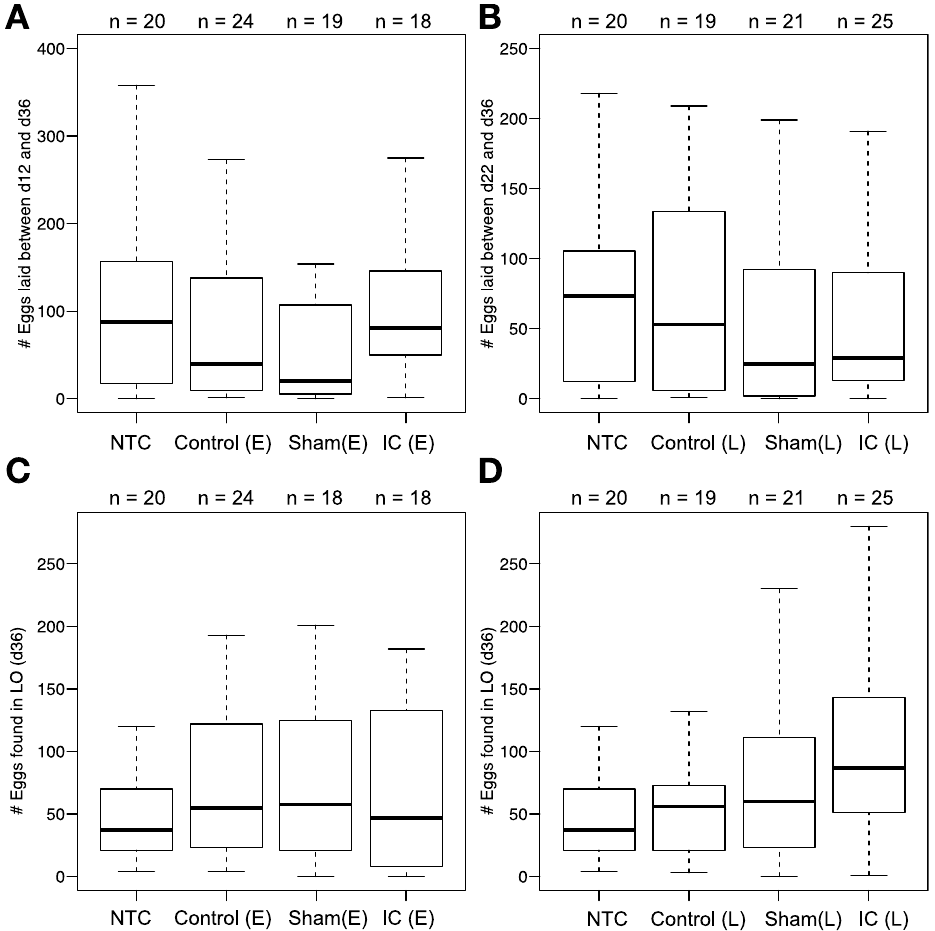
Fig 3. No effect of immune challenge on reproductive output. The number of eggs laid between day 12 and 36 (A), day 22 and 36 (B), and the number of eggs found in the lateral oviducts (C and D) are shown across treatment groups. The bars represents the 25 th and 75 th percentile, the central line in bold represents the median and the error bars denote the maximum and minimum values for each group. Statistical information is described in the Results section. No significant difference was found among